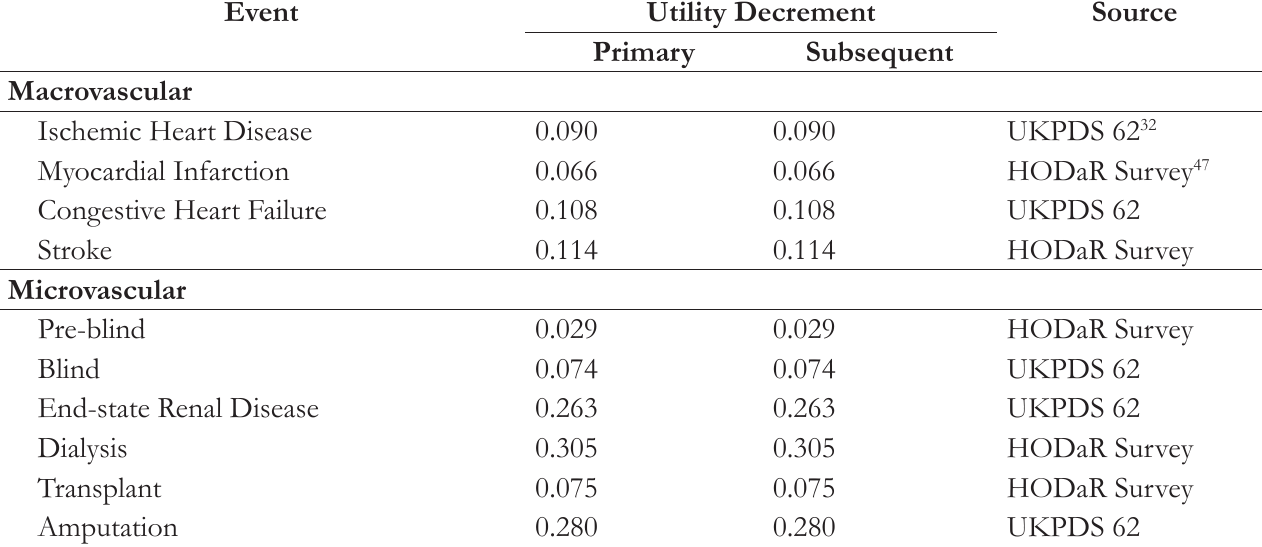
Table 5. Health-related Utility Decrements (EQ-5D) and Associated End